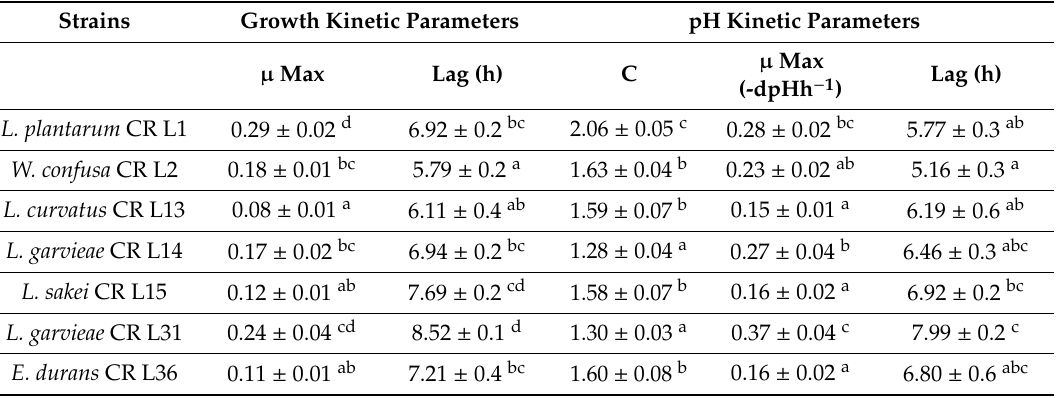
Table 2. Kinetic parameters of lactic acid bacteria growth and acidification in an MRS broth, as modelled according to the Gompertz equation. C: maximum yield; µ max: maximum rate; Lag: length of the lag phase.